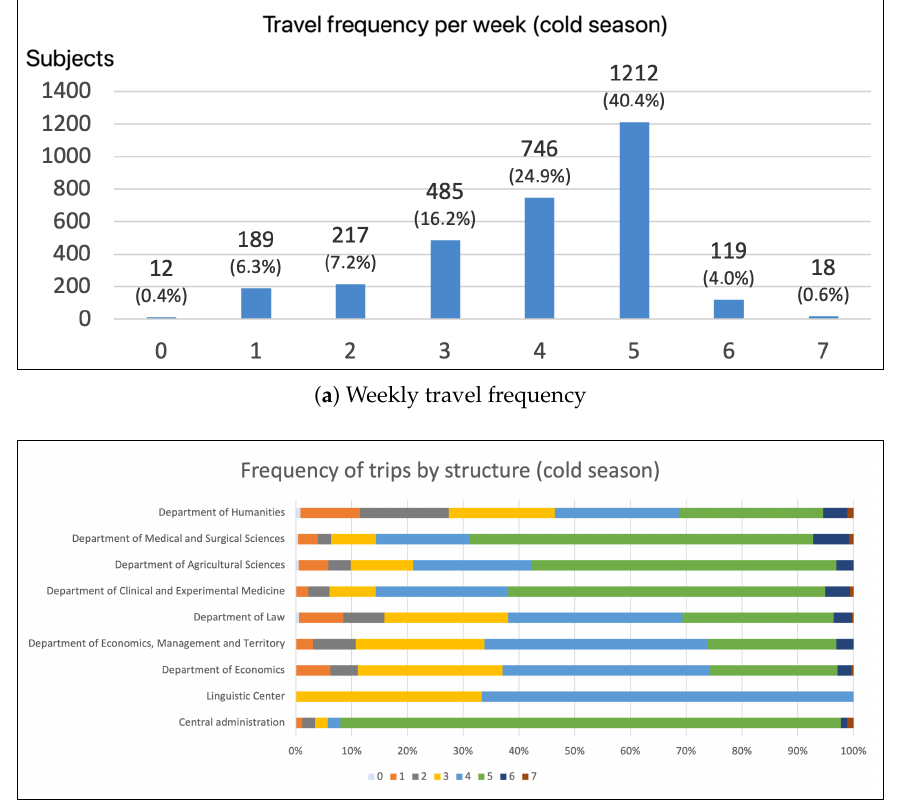
Figure 12. Travel in hot season.